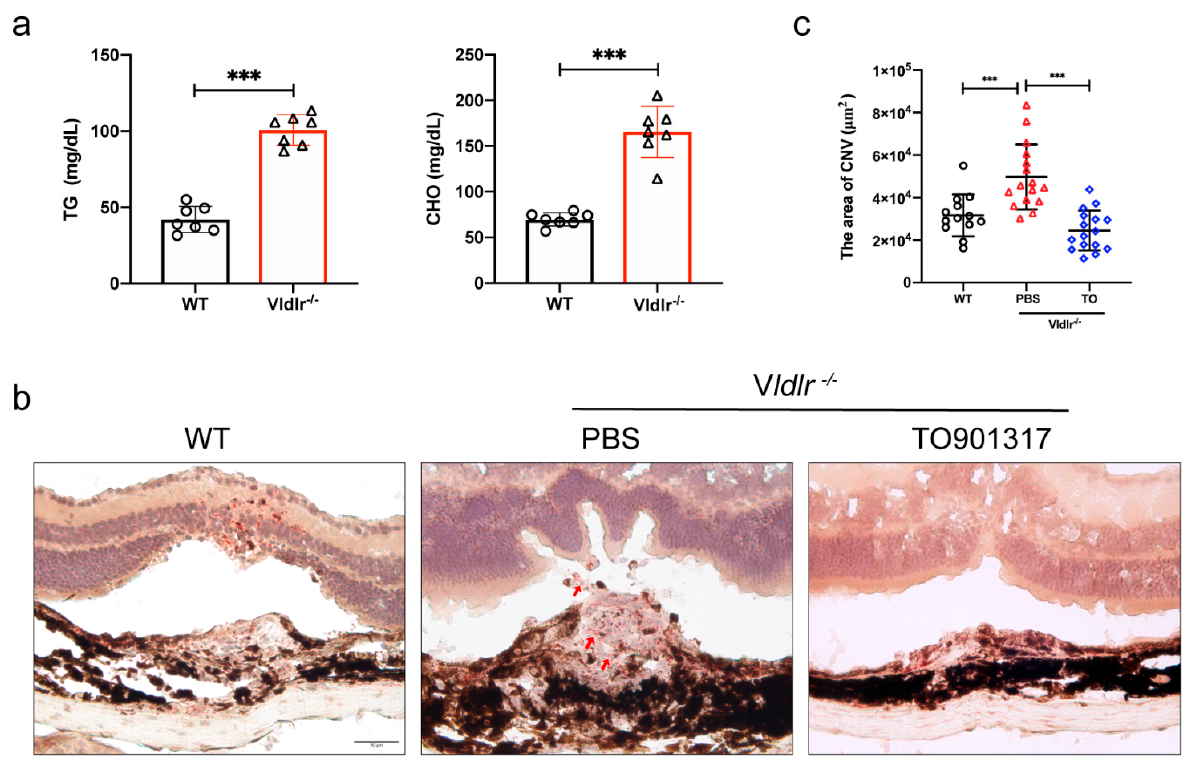
Figure 6. Effect of LXR agonist on Vldlr − / − mice CNV volume. ( a ) Quantification of triglycerides and total cholesterol of Vldlr − / − mice. Values are expressed as means ± SEM, n = 7, *** p < 0.001 vs. WT group. ( b ) Oil red O staining detect lipid accumulation (red), hematoxylin labeled nuclear (blue), arrows labeled lipid accumulation, bars = 50 µ m. ( c ) Quantification of CNV relative 2D lesion areas. Lesion areas were measured using ImageJ software. Values are expressed as means ± SEM, n = 15, *** p <